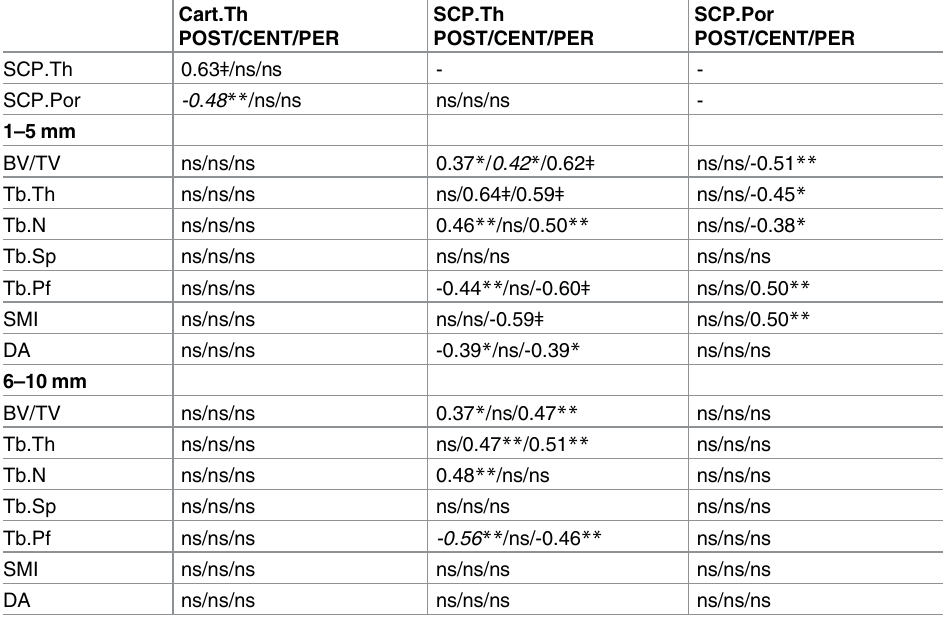
Pearson correlation coefficients (Spearman correlation coefficients in italics for non-normally distributed data) among trabecular architecture parameters and subchondralplate thickness and porosity at three sampling sites in the medial tibial plateau: central (CENT, uncovered), peripheral (PER, fully covered), and posterior (POST, partially